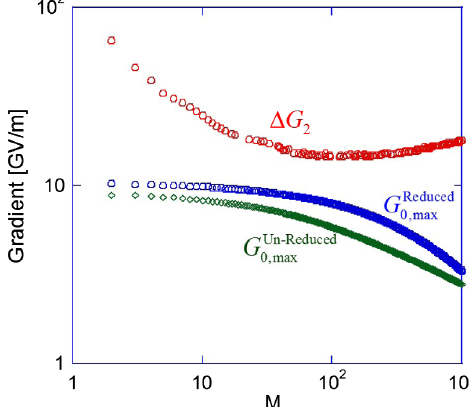
FIG. 5. The amplitude correction Δ G 2 (red) dependence on the number of bunches in the train for the optimal charge in Fig. 4. (blue) is higher than the one for the unreduced case